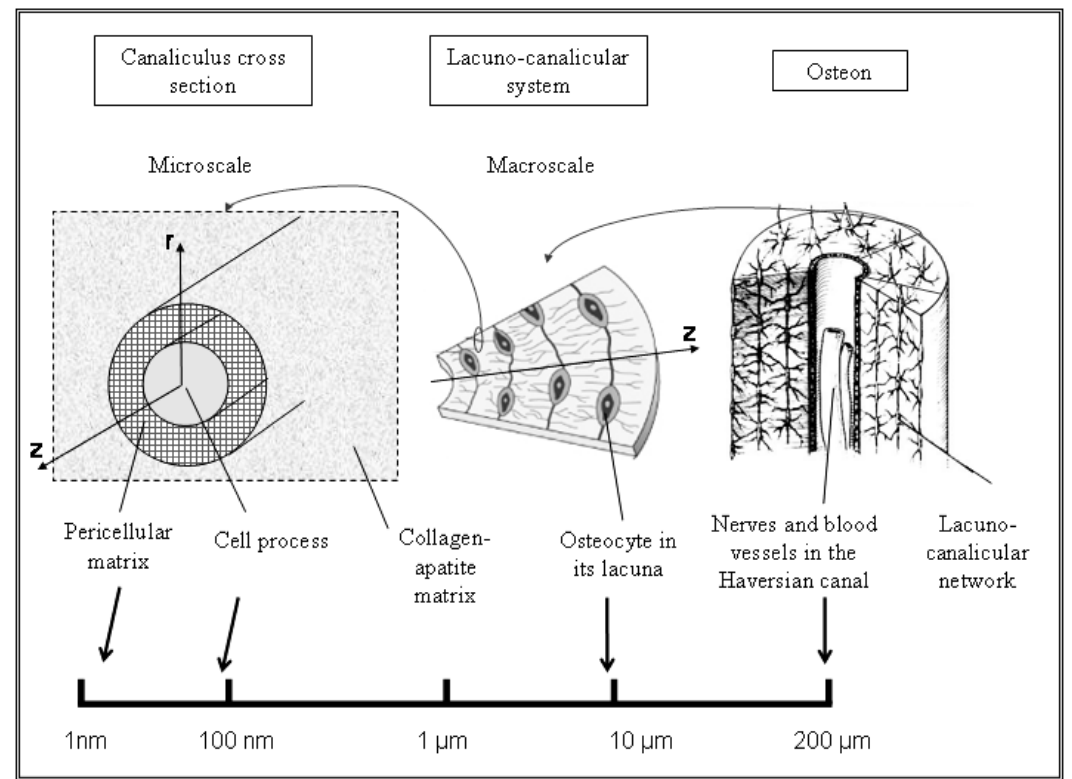
Fig. 1 – Multiscale structure of the cortical bone; the microscale corresponds to the radius of the canaliculi , whereas the macroscale refers to the osteon